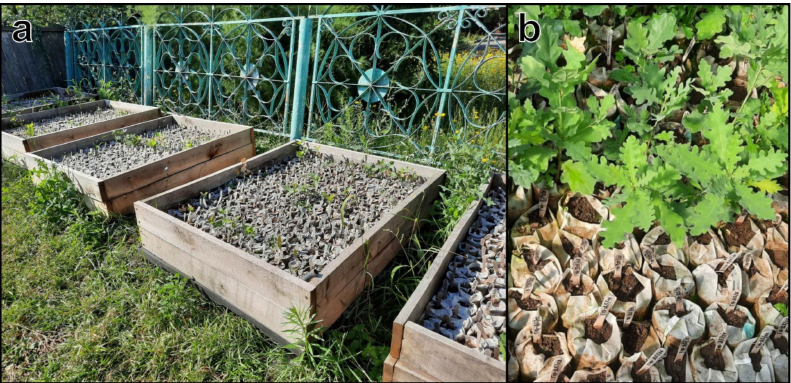
Figure 2. Individual variants of experiment ( a ) and a detailed view of containers with oak seedlings ( b ). During the cultivation of English oak seedlings in containers in the nurseries of the state forest enterprises of the Kharkiv Regional Department of Forestry and Hunting of the State Forestry Agency of Ukraine, we tested different compositions of the substrate containing low-land peat (Peat), which is rich in nutrients and mixtures with different ratios of soil (S), humus (H) and softwood sawdust (SD). The following variants were tested: 1. Soil (control); 2. Peat:S = 1:1; 3. Peat:S = 1:2; 4. Peat:S = 2:1; 5. Peat:S = 3:1; 6. S:H:SD = 1:1:1; 7. S:H:SD = 2:1:1; 8. S:H:SD = 3:2:1; 9. S:H:SD =